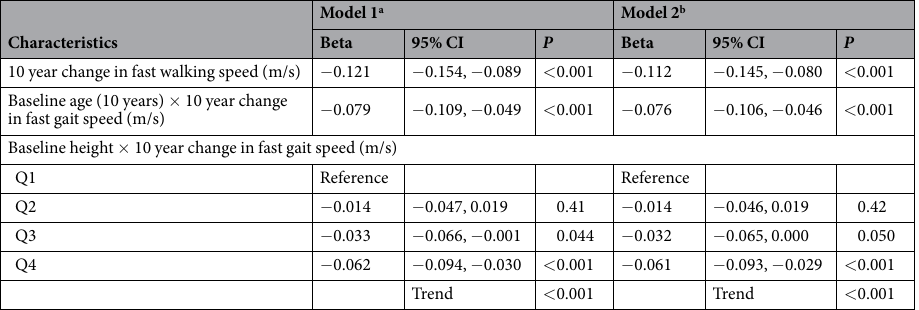
Table 3. Association Between Height at Baseline and Change in Fast Gait Speed Over the Follow-up (N = 4,011). Beta, regression coefficients; CI, confidence interval; Q1 (shortest)-Q4 (tallest), sex-specific quartiles of height; BMI, body mass index; MMSE, mini-mental state examination. Please see the supplementary methods for the equations corresponding to the models presented in the table. a Adjusted for sex (reference, women), education (reference, low education), time-dependent BMI (reference, < 25 kg/m 2 ), baseline height (reference, Q1), baseline age (centered at 65 years), baseline height × baseline age. b Model 1 + time-dependent covariates: MMSE (reference, highest tertile), bone fracture (reference, no),